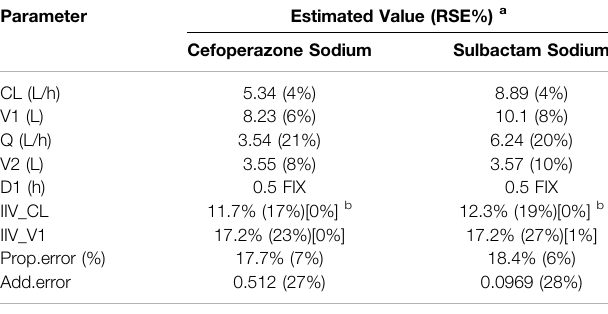
TABLE 6 | Parameters estimates obtained from the human Pop-PK model of cefoperazone sodium and sulbactam sodium.